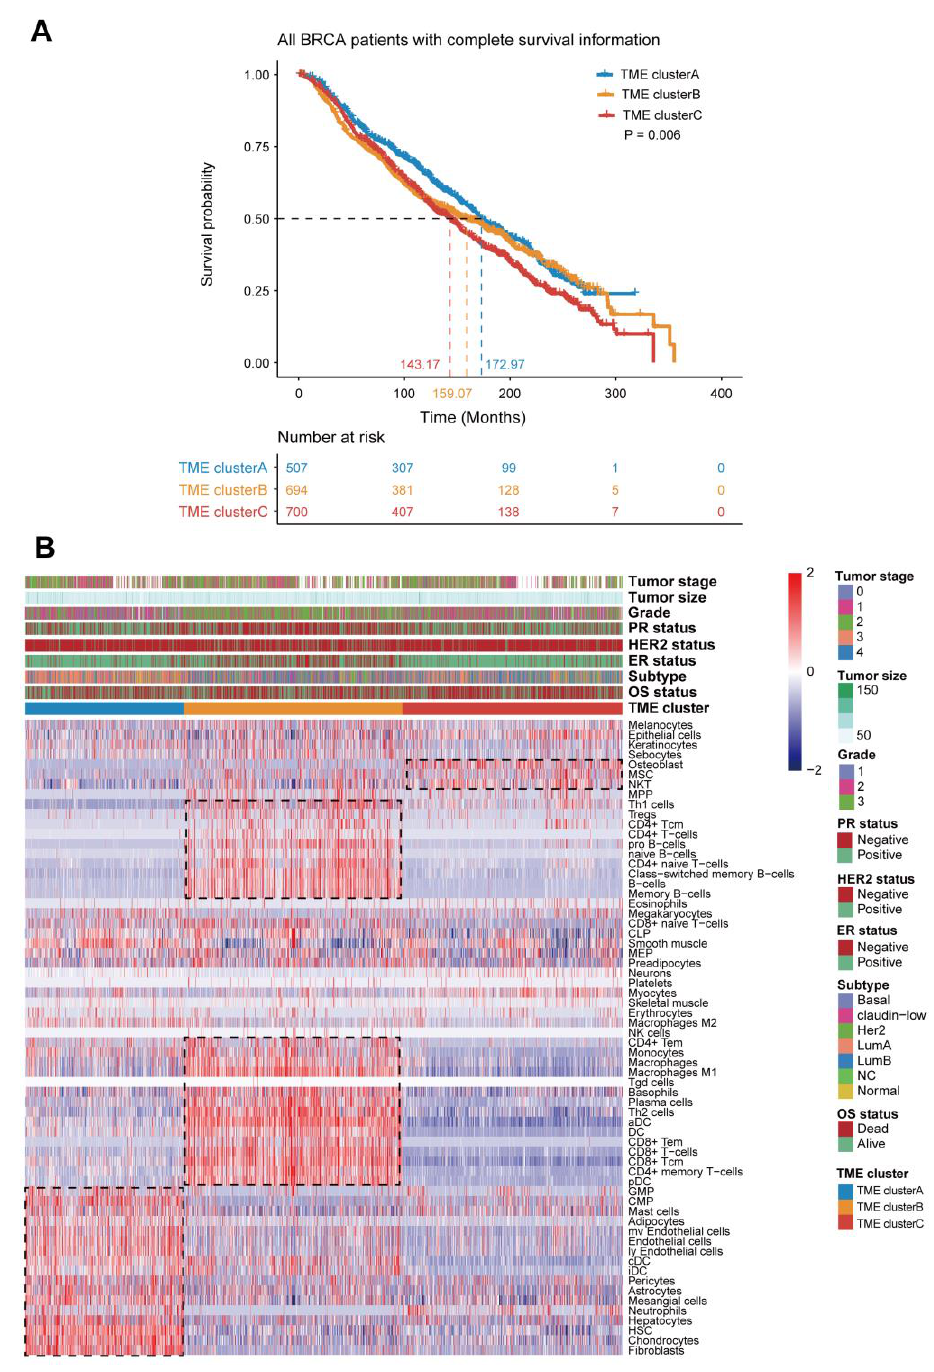
Figure 2. The landscape of the TME in breast cancer and characteristics of TME subtypes. ( A ) Kaplan–Meier curves for overall survival (OS) of all BRCA patients with three TME subtypes. The log-rank test showed an overall p = 0.006. ( B ) Consensus clustering of tumor-infiltrating cells in Bernard cohorts. Rows represent tumor-infiltrating cells, and columns represent samples.